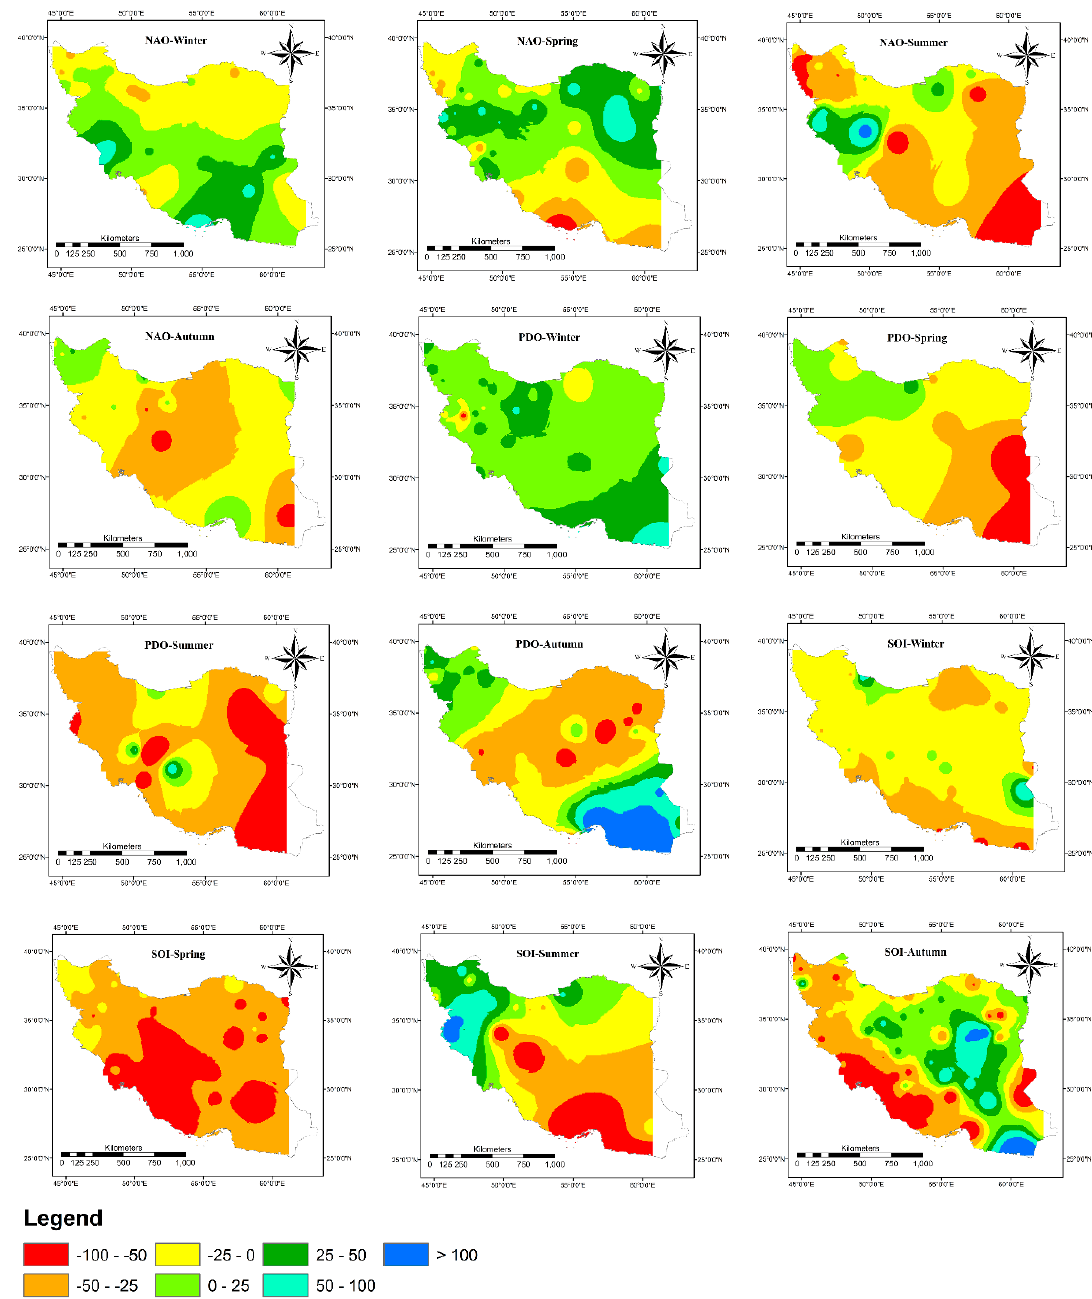
Figure 9. Total change in precipitation due to the effect of SOI, NAO, and PDO in the range of 1 < x < 2, where x denotes the SOI, NAO, and PDO value.